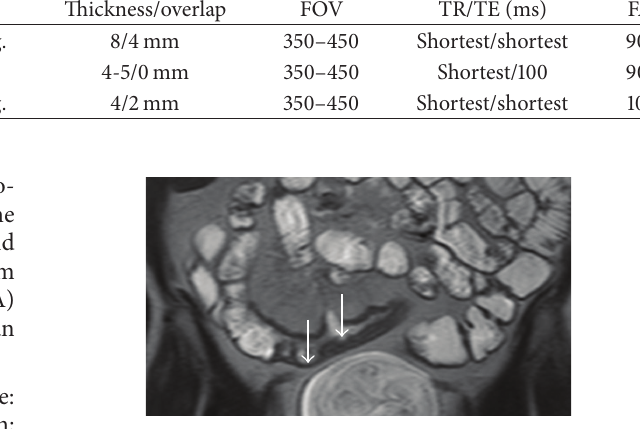
Figure 1: MRE, T2W coronal image. Ulcerations were diagnosed when irregular mucosal depressions were recognized within a thickened loop (arrow).